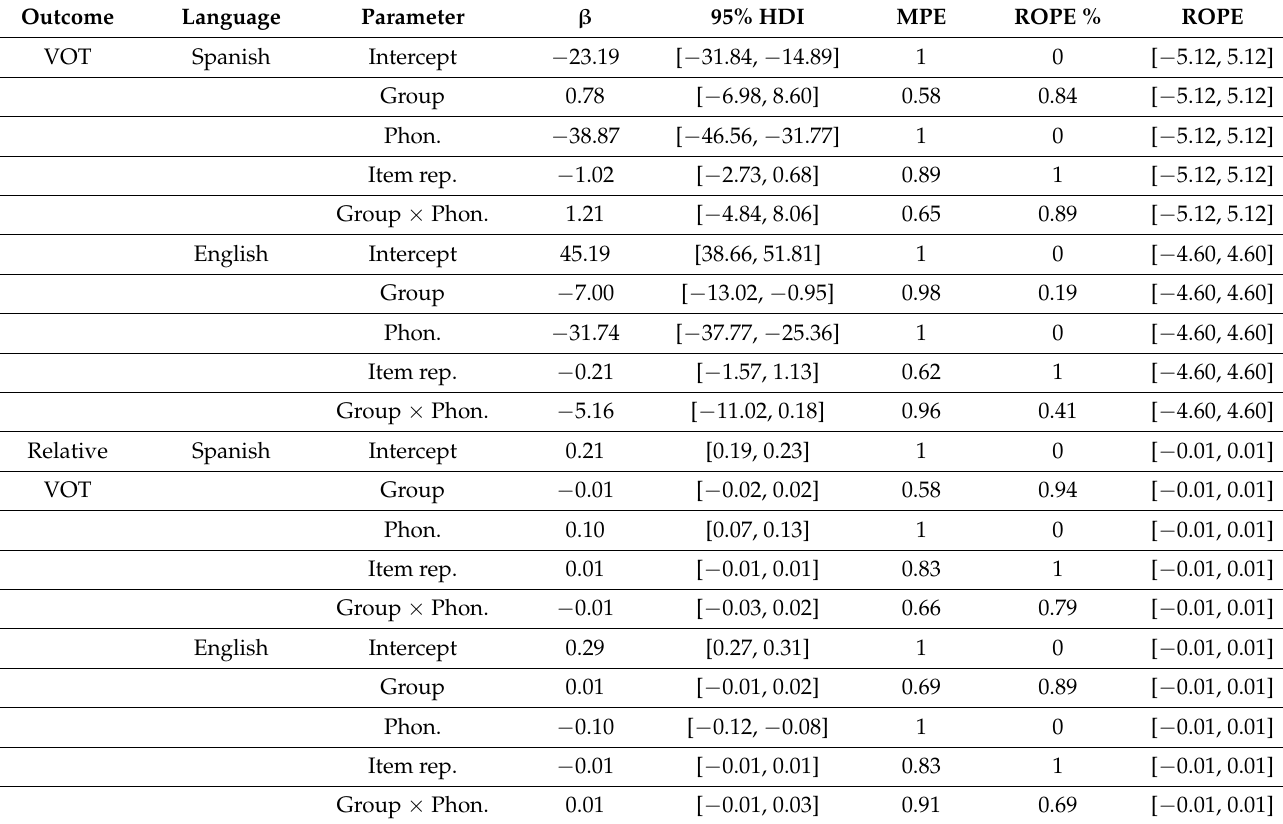
Table 1. Summary of the posterior distribution modeling voiceless responses as a function of VOT, context, z-LexTALE, and order. The table includes posterior means, the 95% HDI, the percentage of the HDI within the ROPE, and the maximum probability of effect